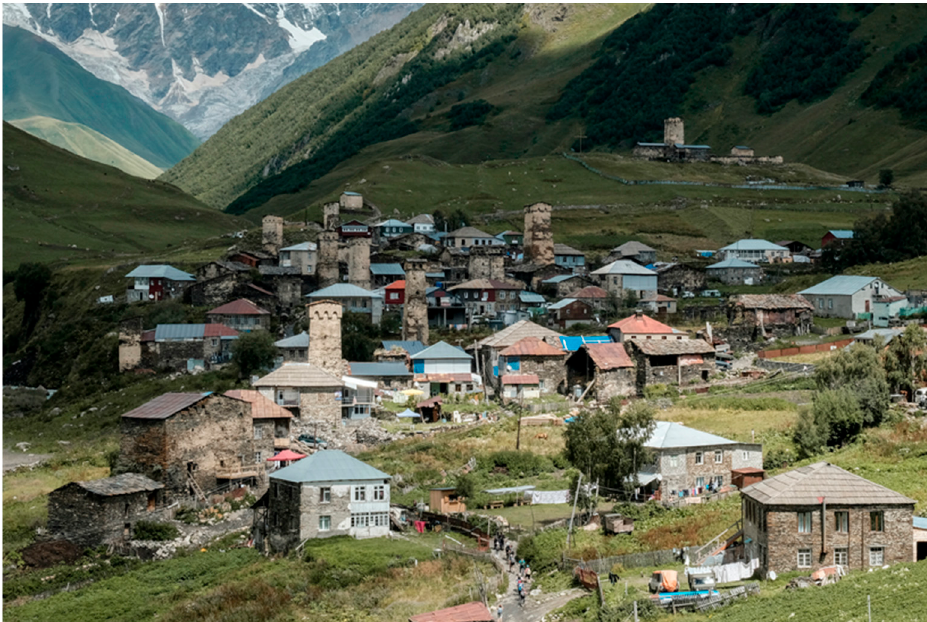
Figure 2. The upper villages of Ushguli with Mount Shkhara in the background (Applis 2019).